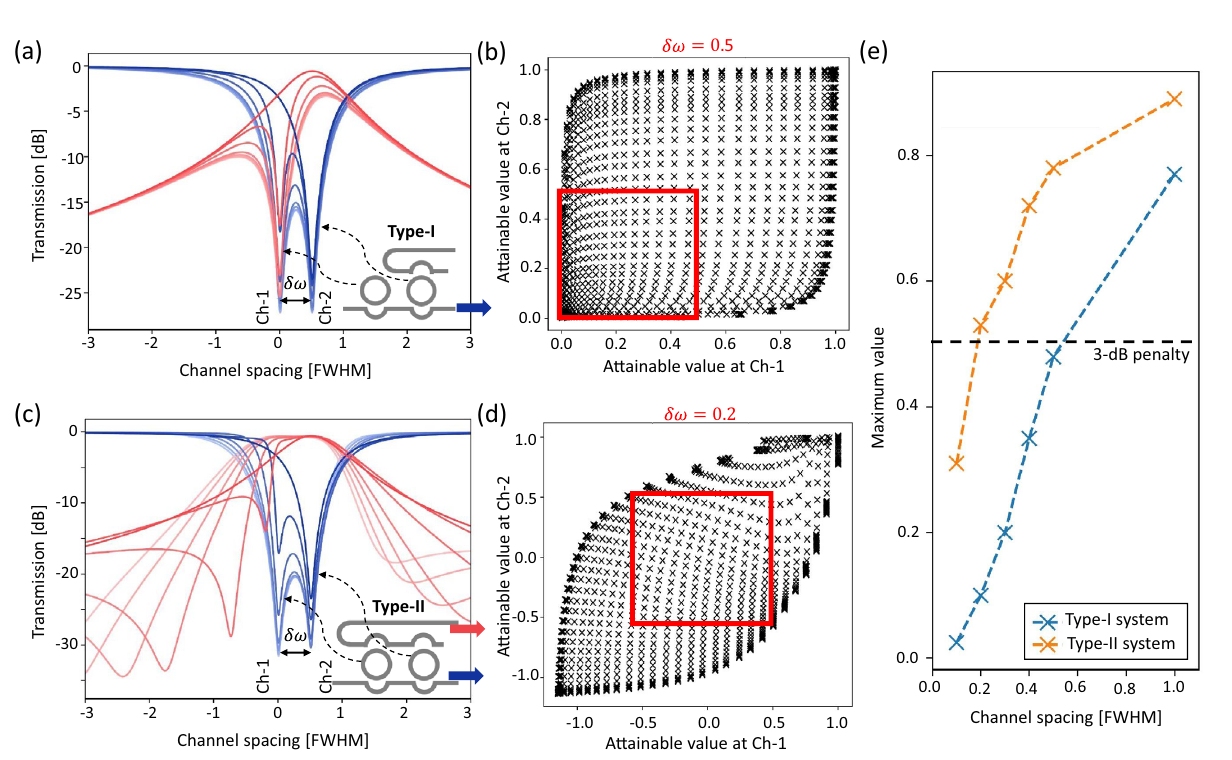
Figure 6. ( a ) Simulated transmission spectra at through (blue) and drop (red) ports of a system with an all-pass MRM cascaded with an add-drop MRR filter (Type-I), the linewidth-normalized channel spacing is set to 0.5. Inset: Schematic of the Type-I system, where the left-hand MRR filter generates the resonant peak at Channel-1 and the right-hand one generates the resonant peak at Channel-2. ( b ) Attainable values for Channel-1 and Channel-2 of Type-I system with δω = 0.5. The red box shows the usable range of [0, 0.5] for both channels. ( c ) Simulated transmission spectra at through (blue) and drop (red) ports of a system with two cascaded all-pass MRMs (Type-II), the linewidth-normalized channel spacing is set to 0.5. Inset: Schematic of the Type II system, where the left-hand MRR filter generates the resonant peak at Channel-1 and the right-hand one generates the resonant peak at Channel-2. ( d ) Attainable values for Channel-1 and Channel-2 of Type-II system with δω = 0.2. The red box shows the usable range of [–0.5, 0.5] for both channels. ( e ) Attainable mapping range for two types of IM-MRM cascaded systems with the linewidth-normalized channel spacing varying from 0.1 to 1. The dashed line represents the 3-dB power penalty